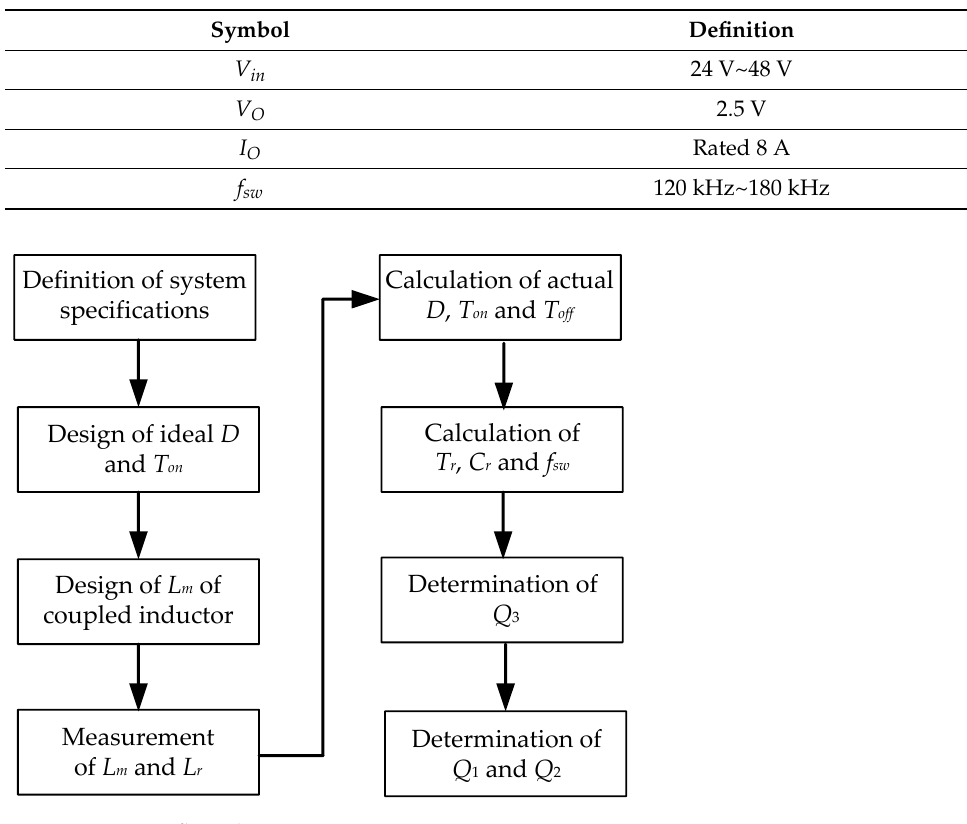
Figure 6. Design flow chart.